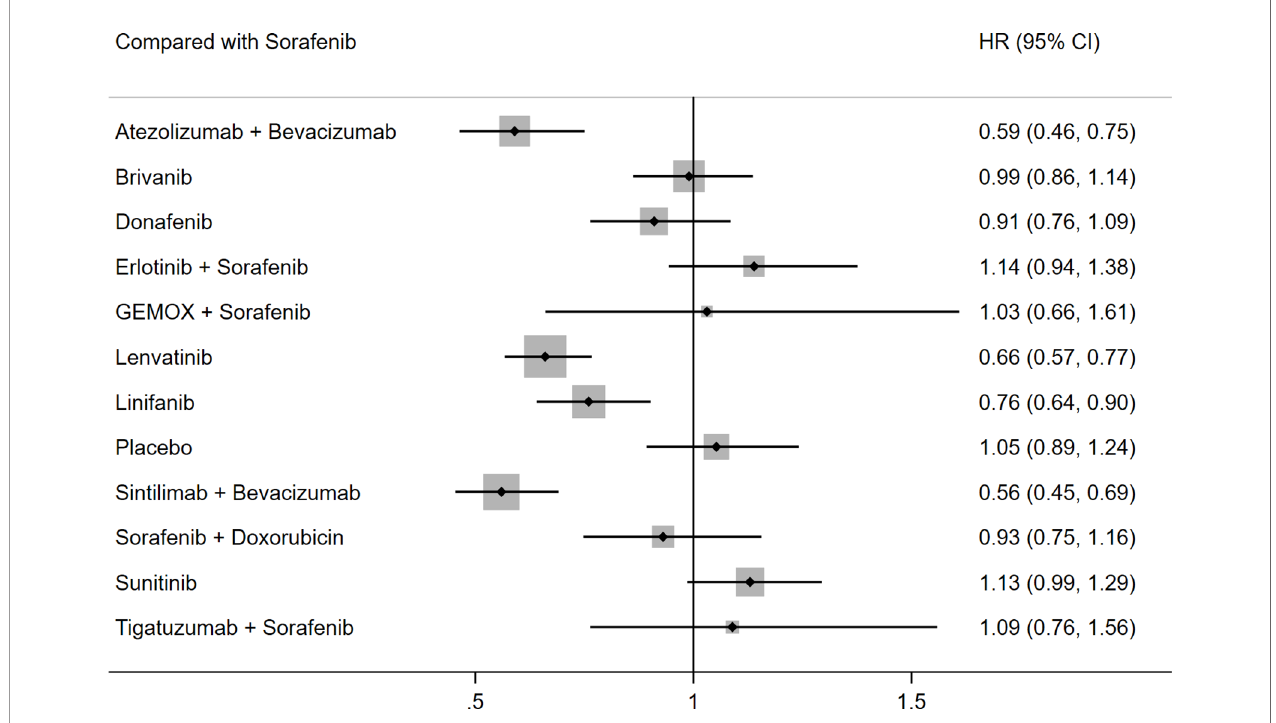
FIGURE 3 | Forest plot for HR of PFS.